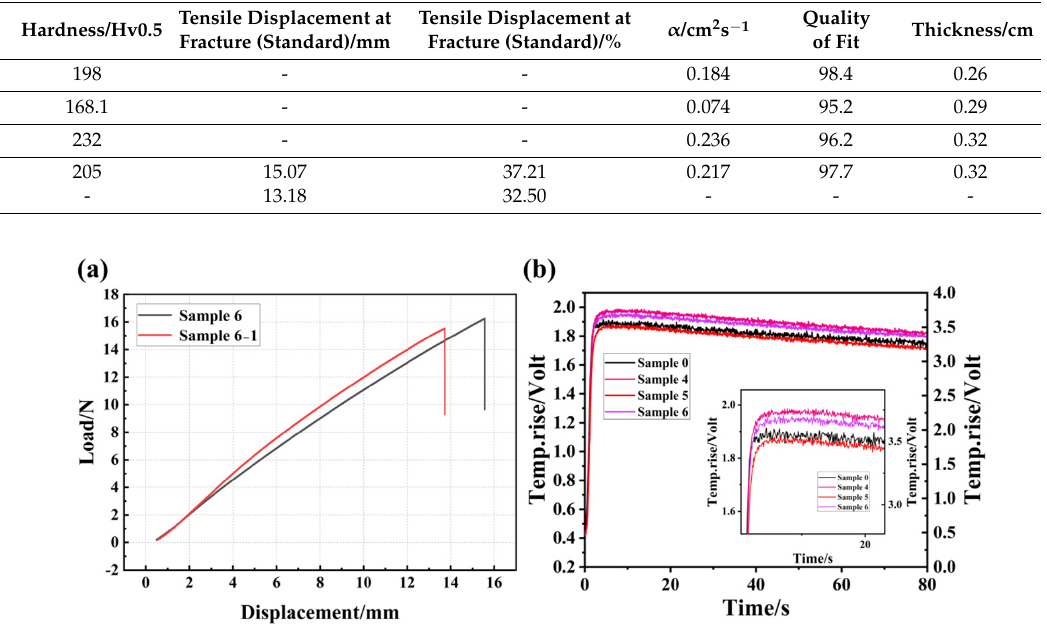
Table 2. Tensile test and Thermal diffusivity results.